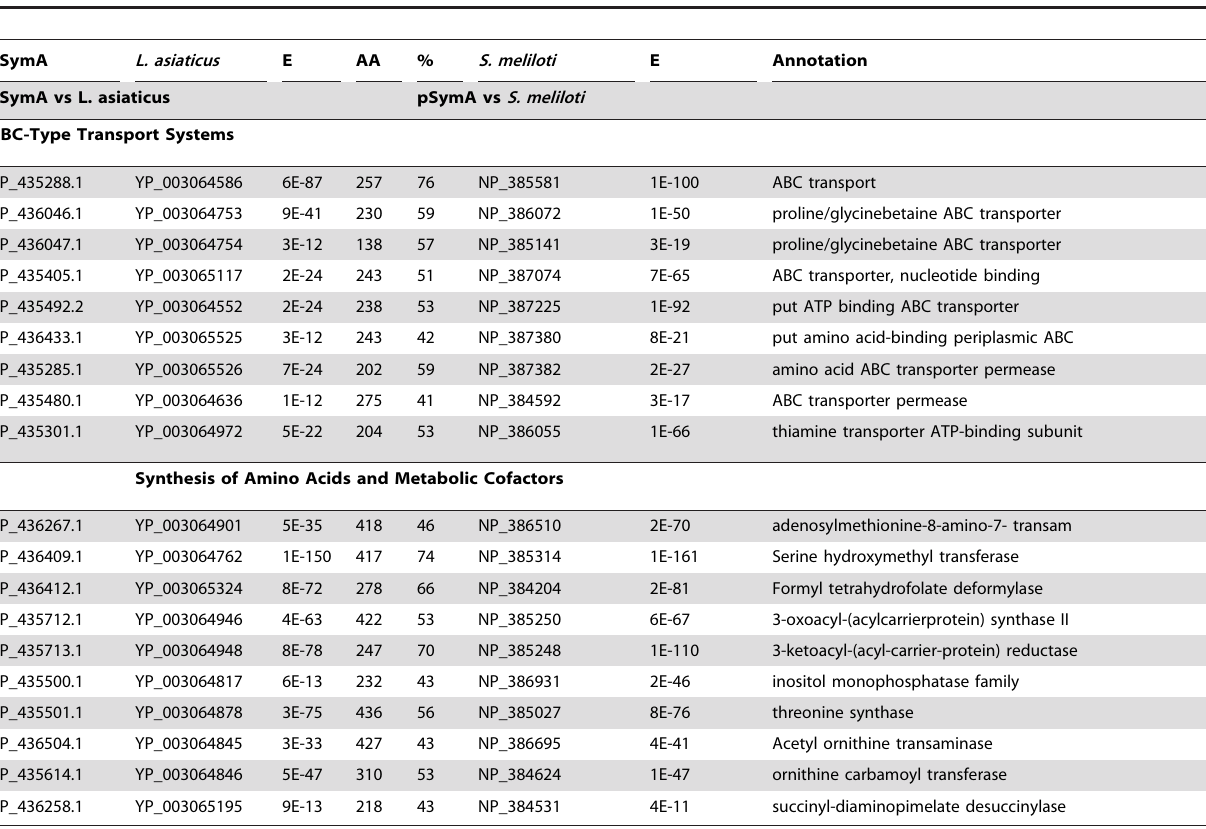
Table 2. Proteins shared between the Sinorhizobium meliloti plasmid pSymA, and the ‘ Ca . Liberibacter asiaticus’ and Sinorhizobium meliloti chromosomes with roles in ABC-Type transport and the synthesis of amino acids and metabolic